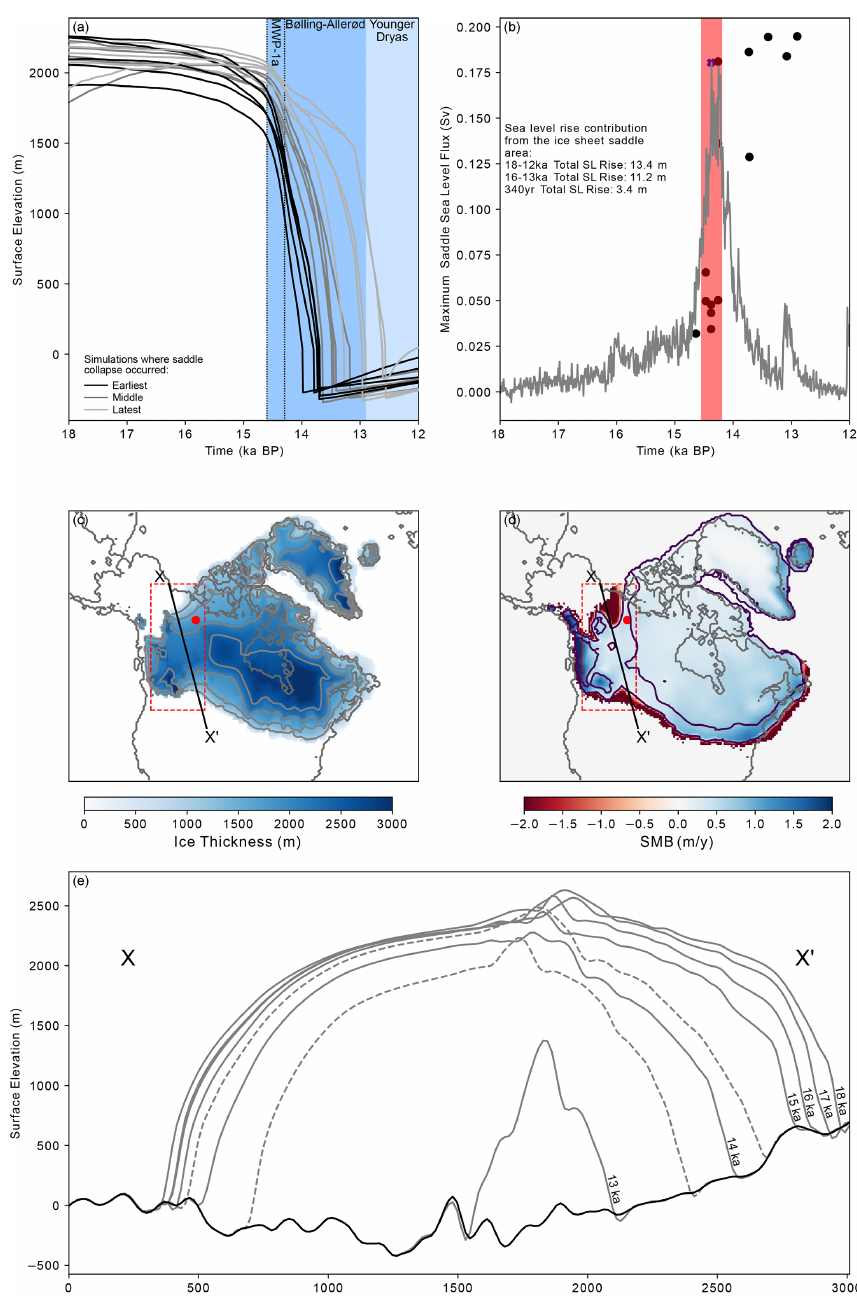
Figure 5. (a) Simulated LIS surface elevations at the Franklin Mountains, 18–12ka, in the 15 selected simulations. Shaded areas indicate the past time periods discussed in this study. (b) Sea level flux from the CIS–LIS saddle area. Black points show the point of maximum sea level flux for each simulation. The grey curve shows the sea level flux evolution for one simulation (Cano_34,; peak marked by a cross), with the 340-year period of peak sea level flux in red. (c) Ice thickness at 15ka for one simulation (Cano_34), with grey contours every 500m from 1000m of ice thickness. The X–X (cid:48) line marks the transect used in panel (e) , the red dot marks our southern sampling sites in the Franklin Mountains where the 10 Be samples were collected, and the dashed rectangle marks the CIS–LIS saddle area used for calculations (same in panel d ). (d) Surface mass balance (SMB) of the North American Ice Sheet Complex at 16ka (Cano_34). Dark and light purple contours mark equilibrium line at 16 and 14ka, respectively, showing the change in SMB that resulted in the CIS–LIS saddle collapse. (e) A transect through the CIS–LIS saddle (Cano_34), at 1000-year intervals from 18ka (greatest extent) to 12ka (smallest extent). The black curve shows topography and the grey curves successive ice surfaces, with dashed lines indicating 500-year intervals during the period of most rapid ice sheet